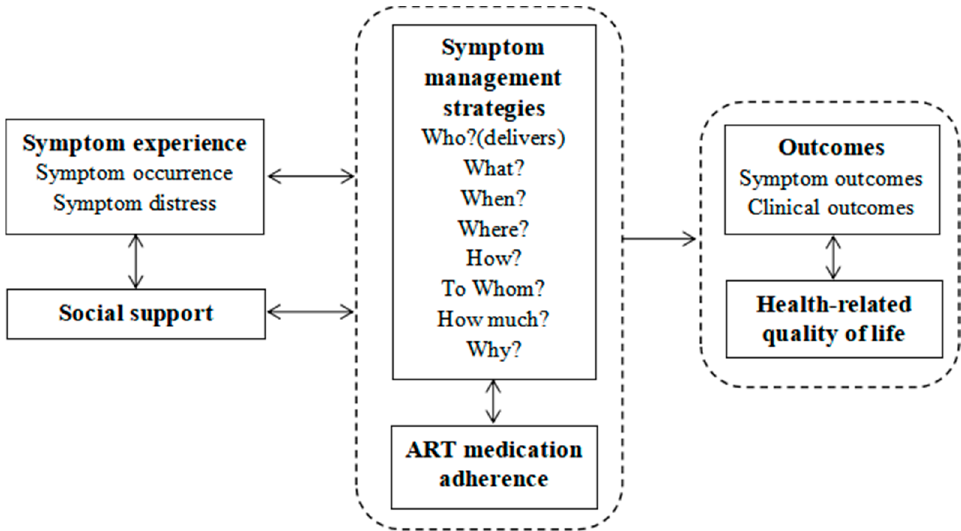
Figure 1. Symptom Management Framework.